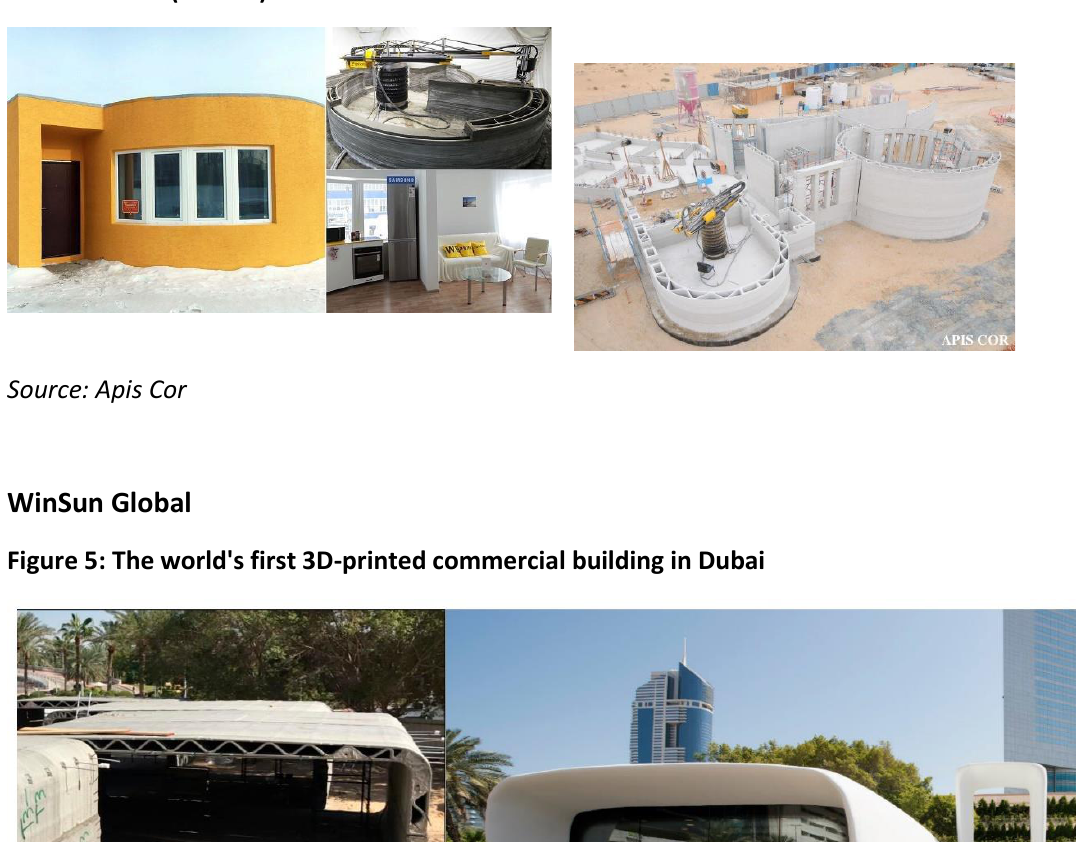
Figure 4: From the tiny house of 38 m² in Russia in 2017 to the world’s biggest printed building in 2019 in Dubai (640 m² )